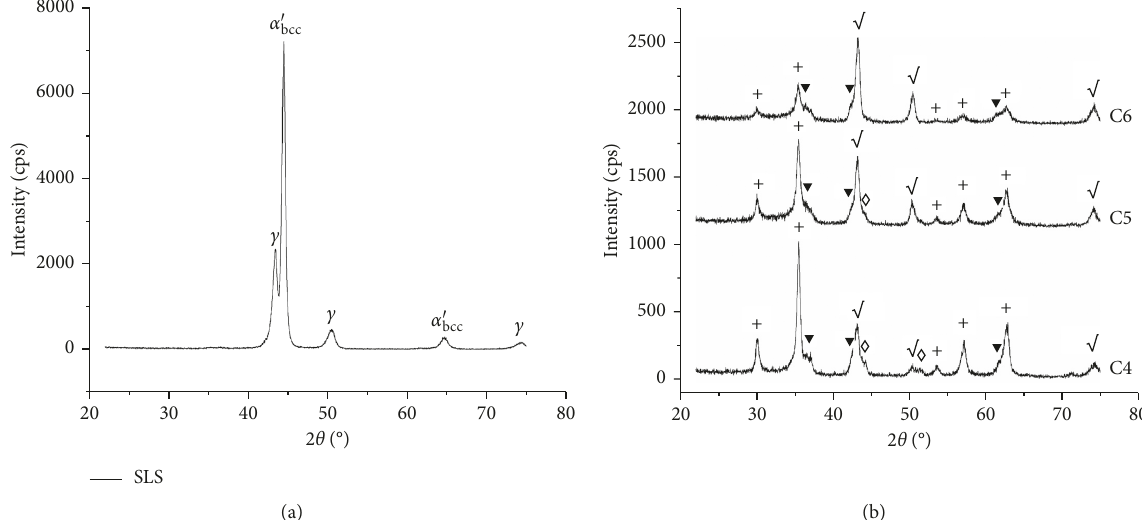
Figure 14: XRD patterns of as-manufactured SLS sample (a) and laser-processed samples (b). α Fe 2 CoO 4 laser-processed surfaces (Figure 14(b)). Other reflections